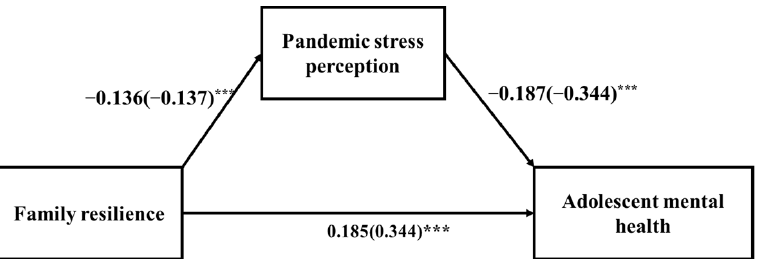
Figure 3. Standardized regression coefficients for the relationship between family resilience and adolescent mental health mediated by pandemic stress perception. *** p < 0.001. Table 9. Effects in the mediation model.